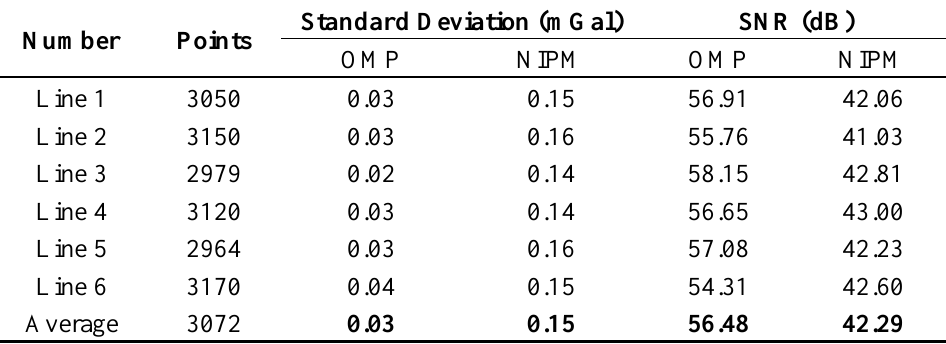
Table 1. The comparison of the algorithm performance for